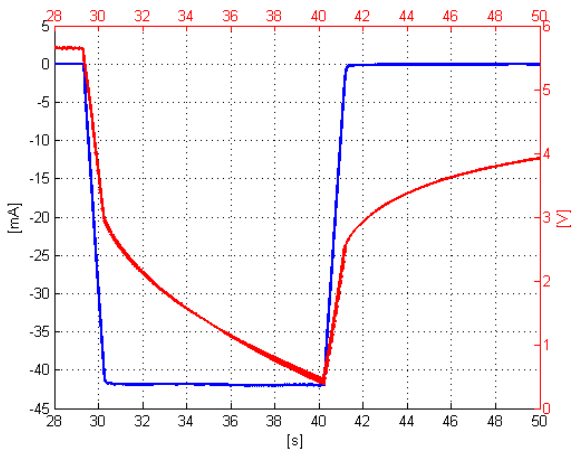
Figure 11. The trapezoidal current pulse and the initial phase of voltage response of SC of 0.47 F capacitance (red line). Energies 2020 , 13 , x FOR PEER REVIEW